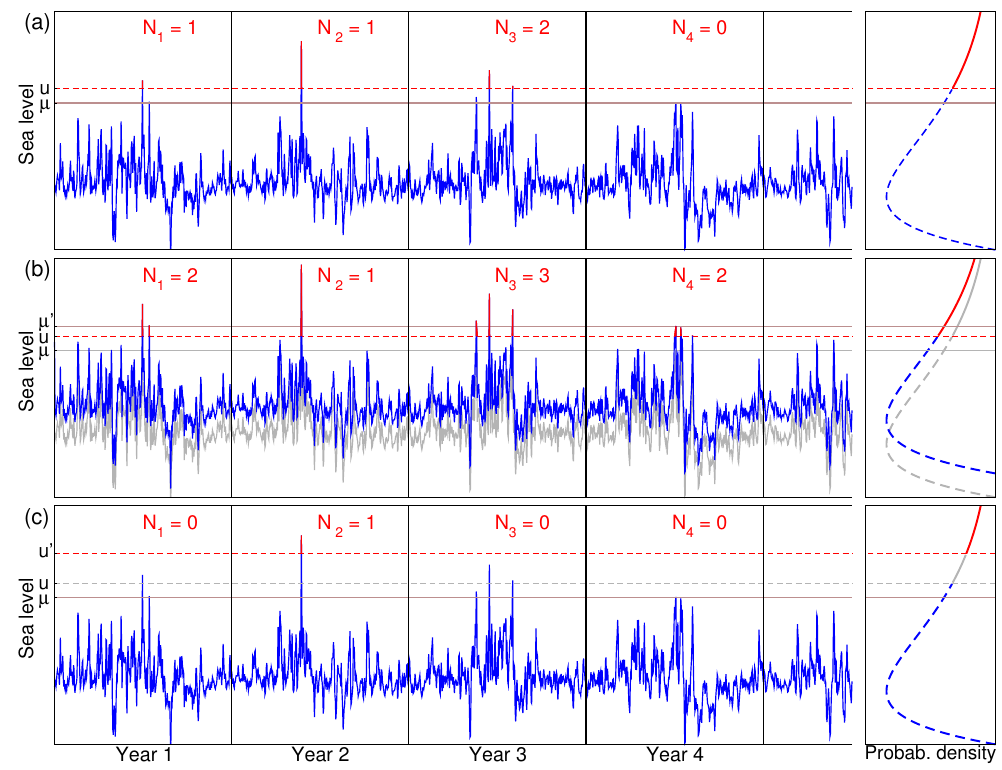
Figure 2. Illustrative time series of sea levels and their probability density function for several scenarios. (a) Current conditions with a thresh- old u and the 1-year event µ . (b) Increased mean sea level with a corresponding shift of the time series and thus the 1-year event from µ to µ (cid:48) . (c) Supposing a protection height of u (cid:48) implying an adjustment of the threshold from u to u (cid:48) . The values N 1 ,N 2 ,... represent in all cases the number of exceedances within the corresponding year. The average value of the N i provides an estimator for occurrence rate (cid:51)